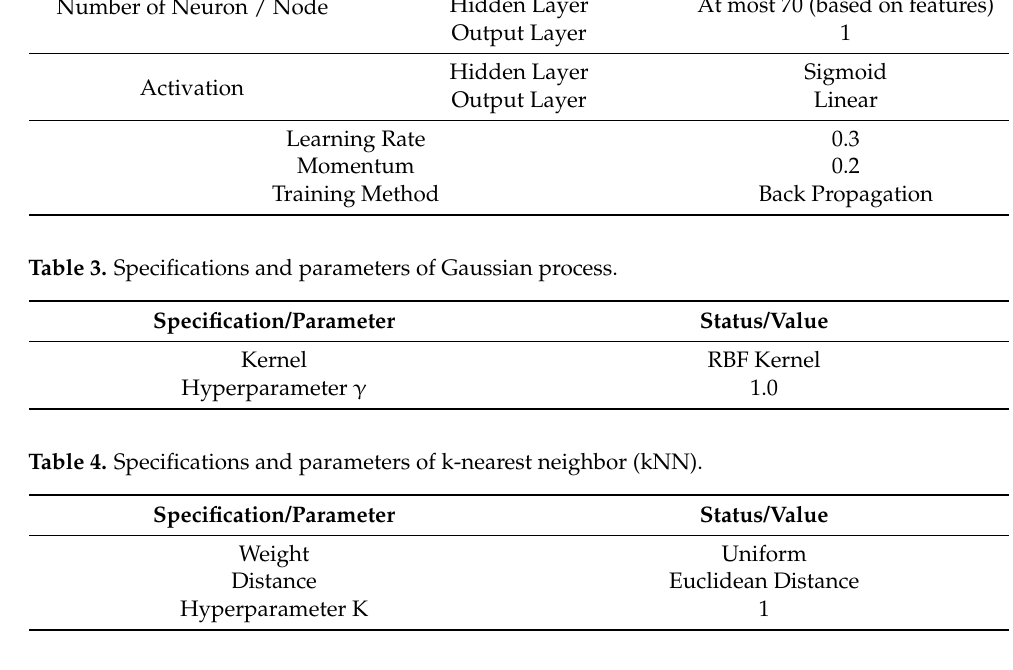
Table 5. Specifications and parameters of linear regression.